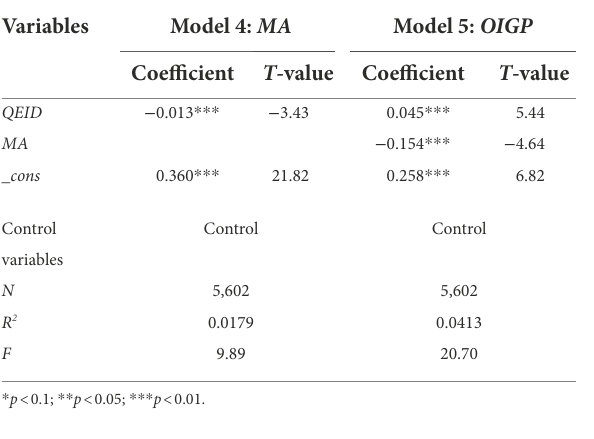
TABLE 6 Results of mediating regression (MA).